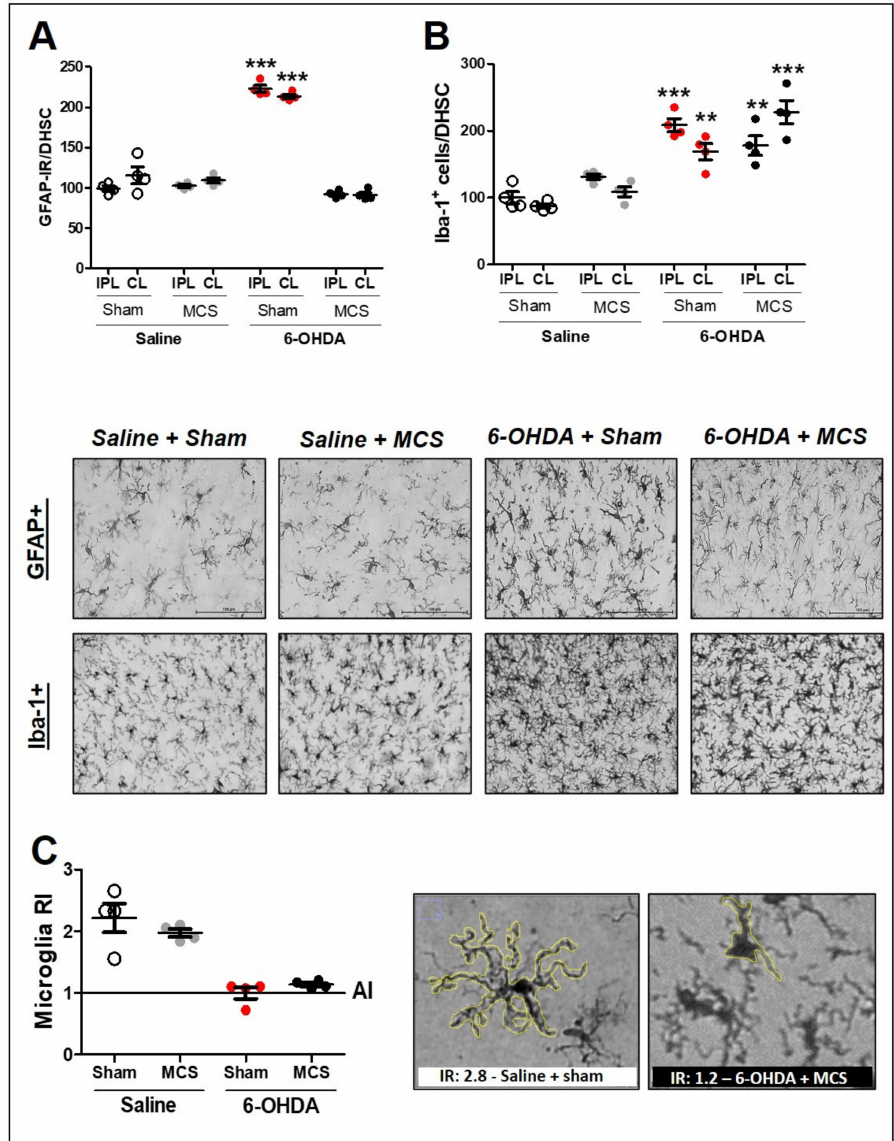
Figure 4. Glial cells in the spinal cord. Astrocytes in the dorsal horn of the spinal cord (DHSC) ( A ). Rats were evaluated in relation to immunoreactivity (IR) for GFAP in the DHSC ( A ). Values represent the mean + SEM normalizing saline + sham as 100% (n = 4 per group). *** p < 0.001 when compared to the control group (saline + sham) (1-w-ANOVA followed by Tukey post-hoc test). Photomicrographs of GFAP-IR of rat saline + sham, rat saline + MCS, rat 6-OHDA + sham, and rat 6-OHDA + MCS. Microglia in the DHSC ( B , C ). Rats were evaluated in relation to number of Iba-1 positive cells (hyperplasia—( B )). Values represent the mean + SEM normalizing saline + sham as 100%. ** p < 0.01; *** p < 0.001 when compared to the control group (saline + sham). Ramification index (RI) of microglial cells ( C ). Values represent the mean + SEM where values similar to 1 indicate an amoeboid morphology. Photomicrographs demonstrating the morphology difference between saline + sham and 6-OHDA + MCS. 6-OHDA, 6-hydroxydopamine; AI, activation index; MCS, motor cortex stimulation; IPL, ipsilateral to the lesion; CL: contralateral to the